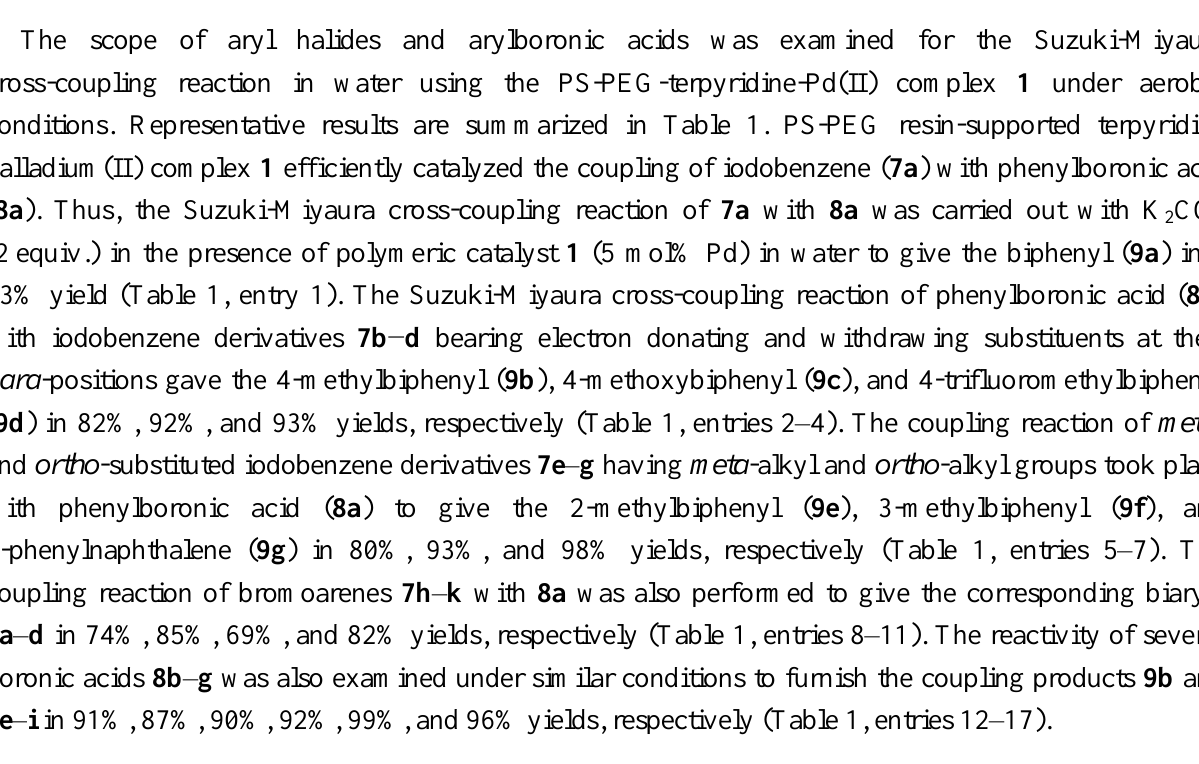
Table 1. Suzuki-Miyaura coupling reaction using polymeric catalyst 1 in water a, b